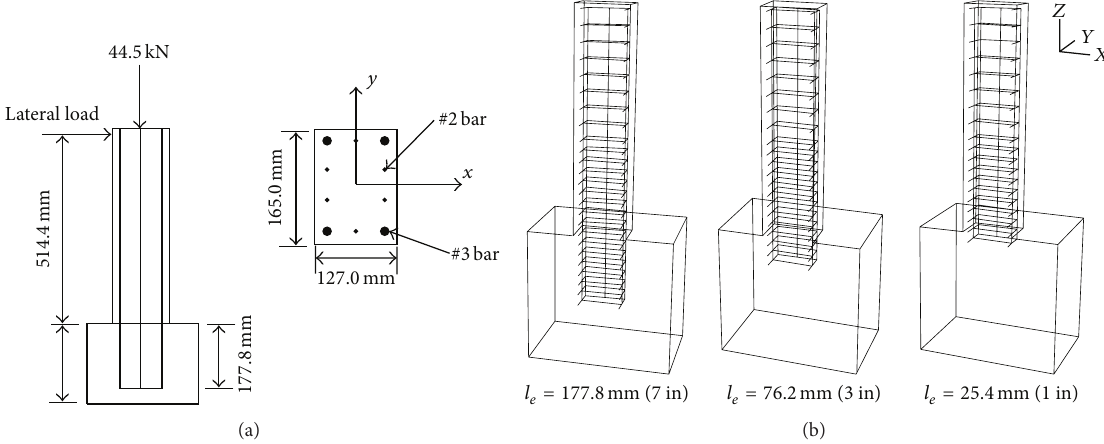
Figure 5: Verification model: (a) test specimen of Low and Moehle [6] and (b) verification model for different embedment depths of reinforcing